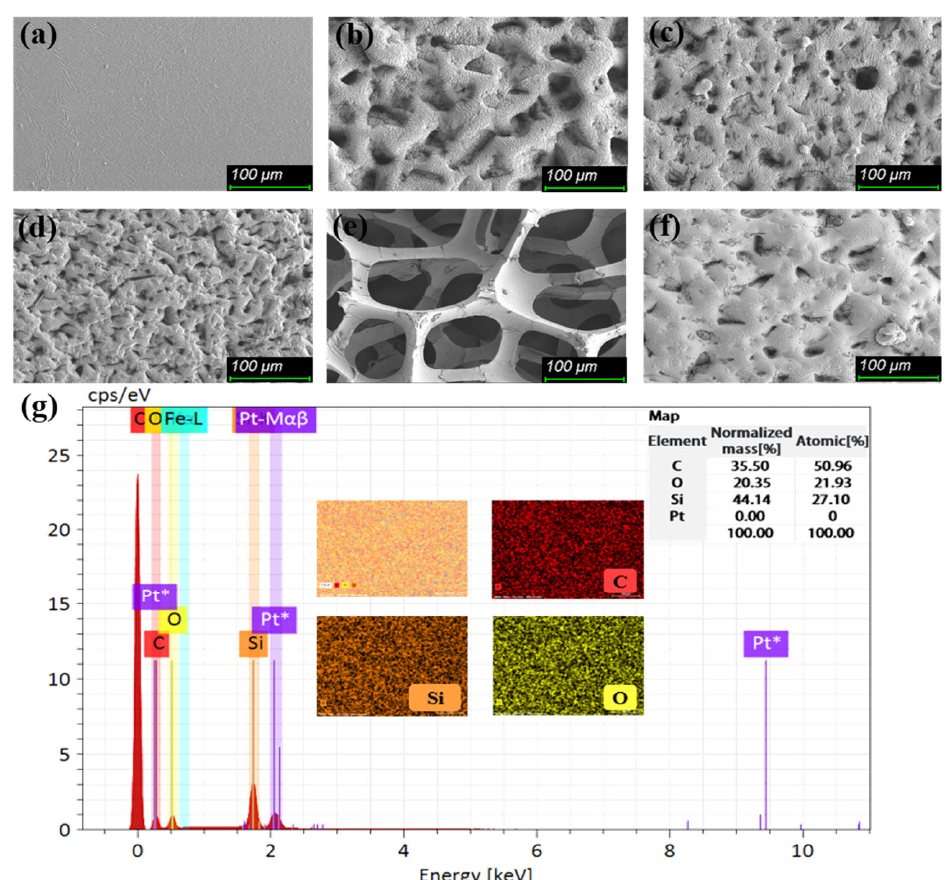
Figure 4. Surface observation of the modified silicone rubber and the conductive sponge: ( a – d ) SEM images of modified silicone rubber with different sandpaper templates (320, 500, 800 grit, respectively); ( e ) SEM image of conductive sponge; ( f ) SEM image of modified silicone rubber after continuous work; ( g ) EDS image of modified silicone rubber with 3% MWCNT concentration.